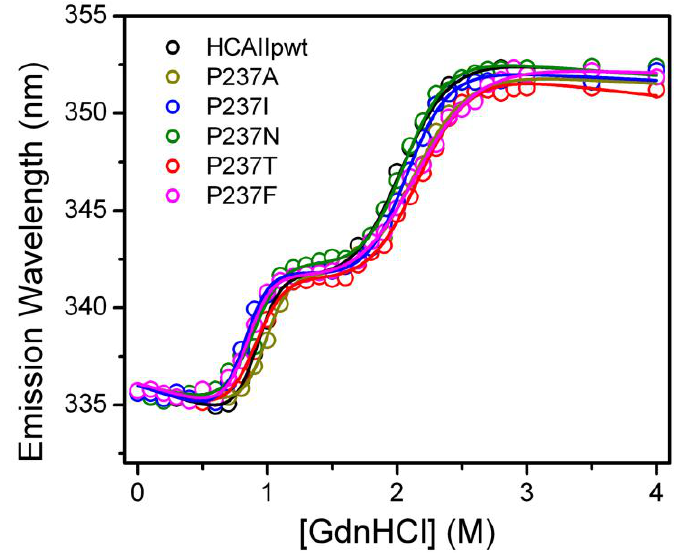
Figure 4. Unfolding transition curves of HCAII maximum wavelength of the intrinsic Trp fluorescence. The raw data were fitted by a three-state model and presented as solid